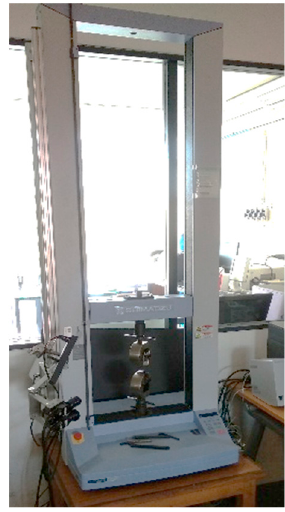
Figure 5. Shimadzu 10 kN tensile testing machine.